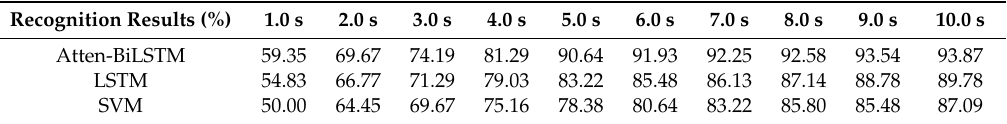
Table 3. The recognition accuracy under di ff erent time window lengths.